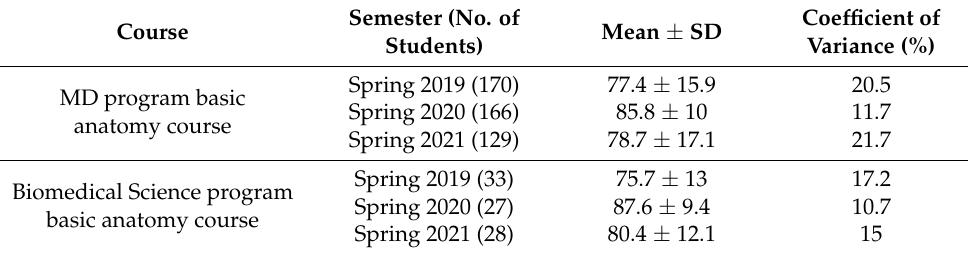
Table 3. Students’ scores in the practical component of basic anatomy courses for MD and BMS programs in three different semesters. CV: Coefficient of variance is calculated as SD/Mean × 100.